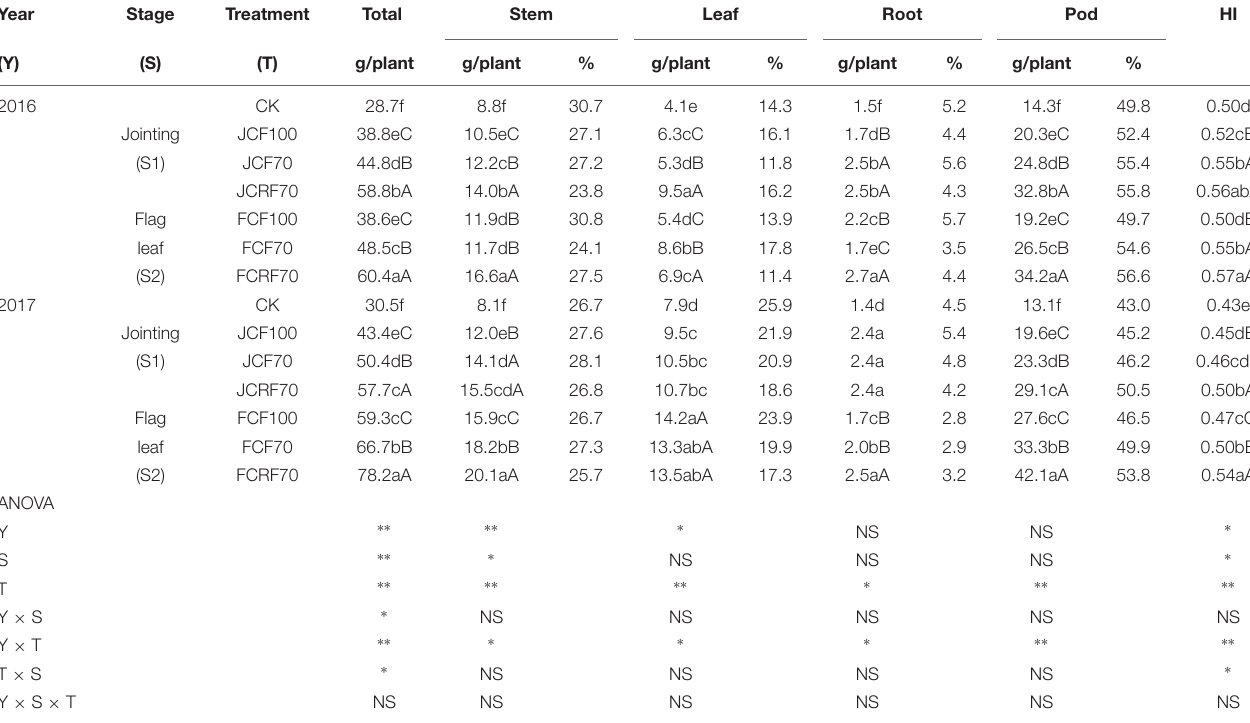
TABLE 4 | Effect of different N fertilizer management regimes on dry matter accumulation (g plant − 1 ) and distribution (%) in peanut at the maturity stage. Year